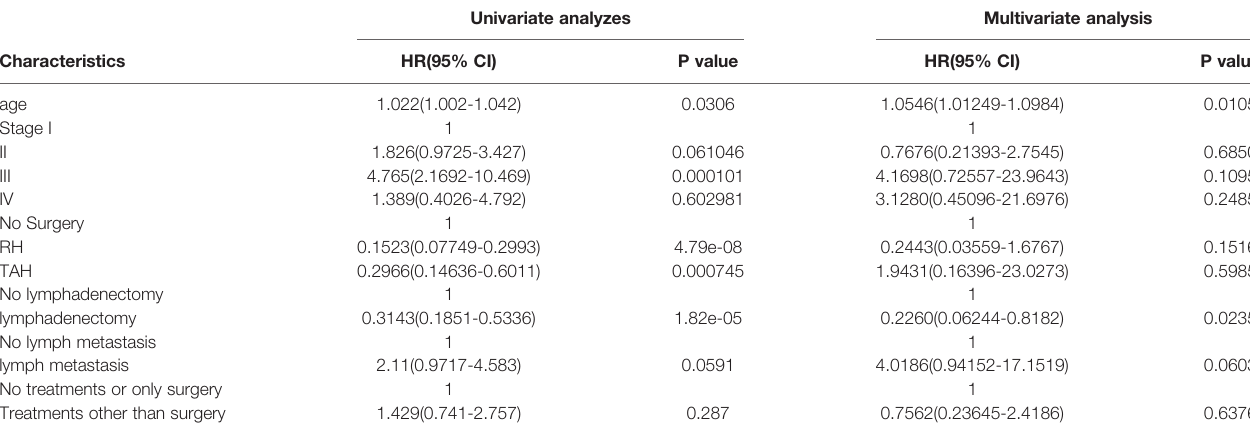
TABLE 2 | Clinical factors effect on overall survival by univariate and multivariate cox proportional hazard regression analysis. Univariate analyzes